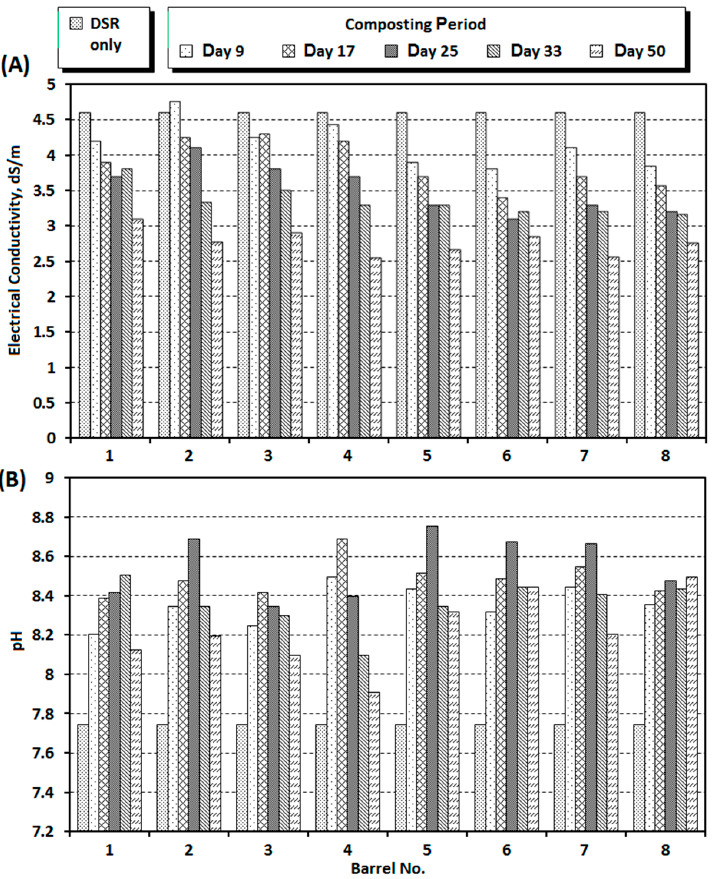
Figure 7. ( A ) Electrical conductivity and ( B ) pH value of composting mass on the 9th, 17th, 25th, 33rd and 50th day of composting period and before mixing DSR with additives. Table 3. Germination parameters of each tested germination